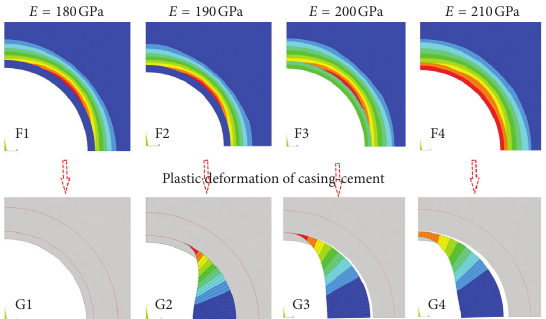
Figure 11: Plastic deformation and microannulus with different casing elastic moduli.